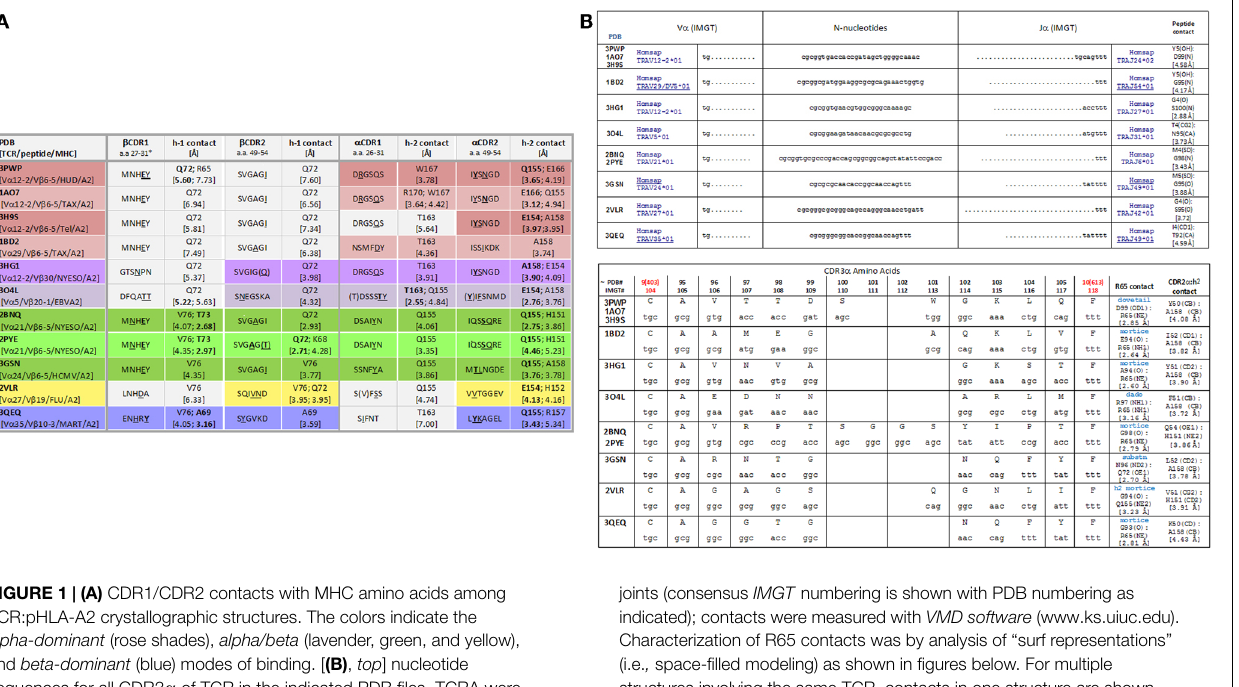
joints (consensus IMGT numbering is shown with PDB numbering as indicated); contacts were measured with VMD software (www.ks.uiuc.edu). Characterization of R65 contacts was by analysis of “surf representations” (i.e. , space-filled modeling) as shown in figures below. For multiple structures involving the same TCR, contacts in one structure are shown, i.e. , for 1AO7 and